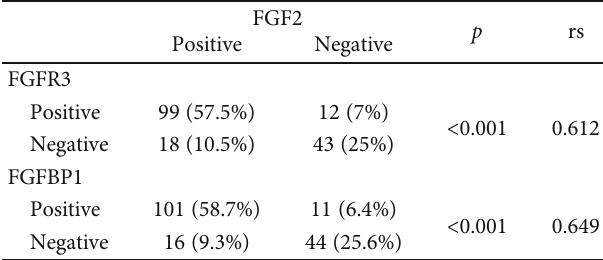
Table 4: Correlation between FGF2 and FGFR3 and